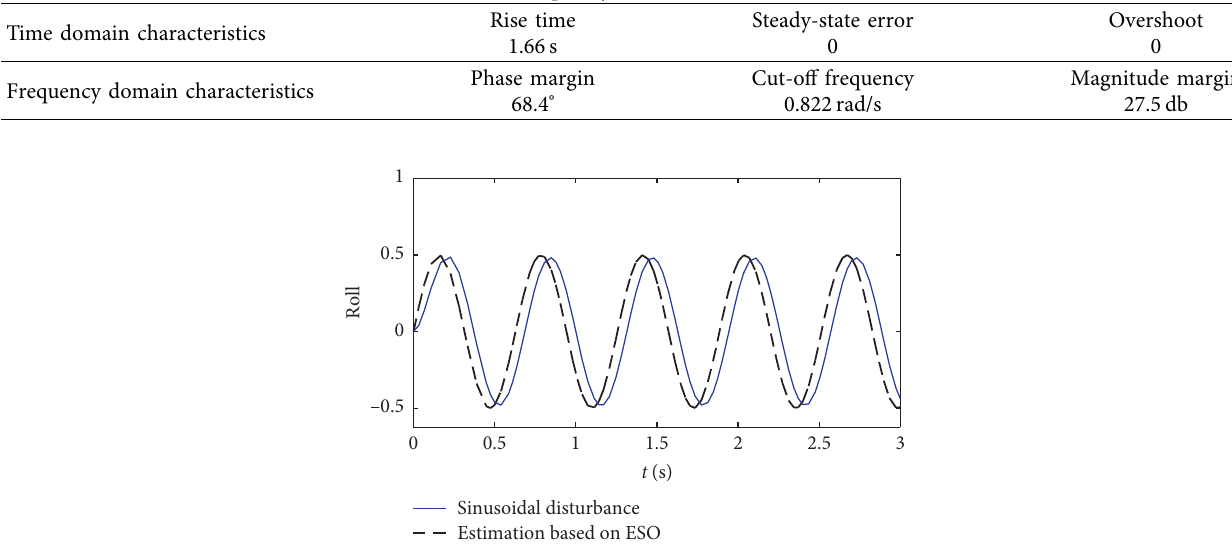
Table 4: The time and frequency domain attributes of the controller.